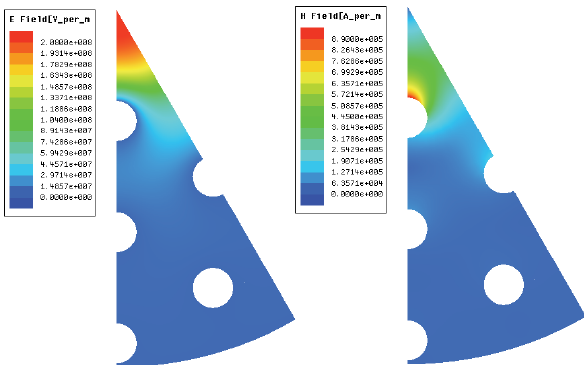
FIG. 9. Electric and magnetic field for PBG structure. Top views for 5.9 MW input power which corresponds to 100 MV = m accelerating gradient.